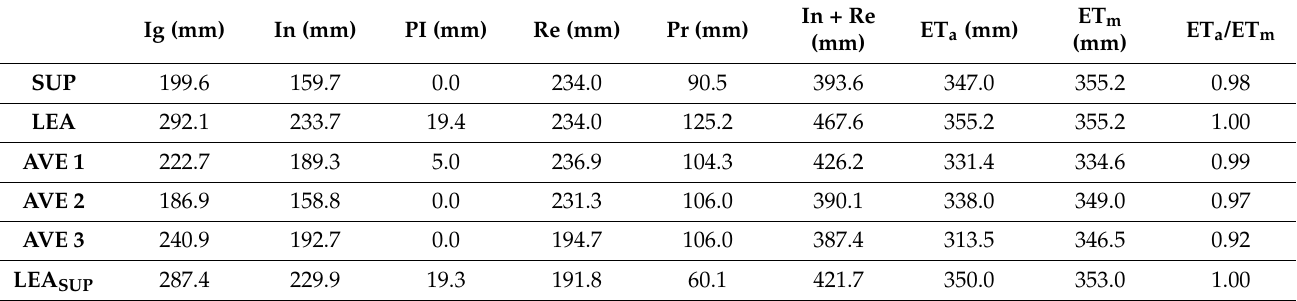
Table 6. Total water received by the crop and ET a /ET m ratio reached at the end of the crop